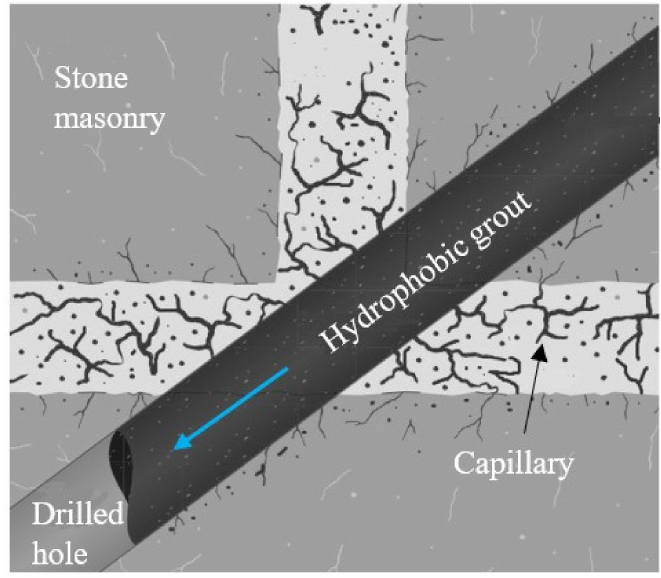
Figure 9. Grouting with hydrophobic mixture.